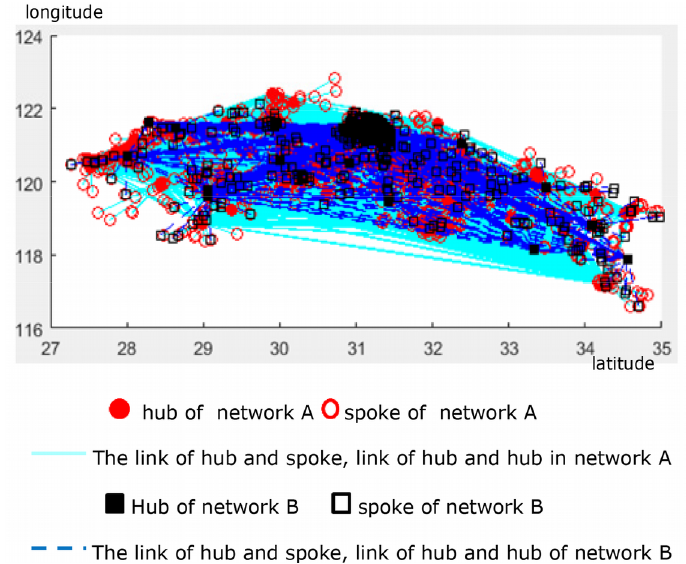
Figure 8. Two overlapping hub- and-spoke network of A and B in the southern region, r = 1,  = 15